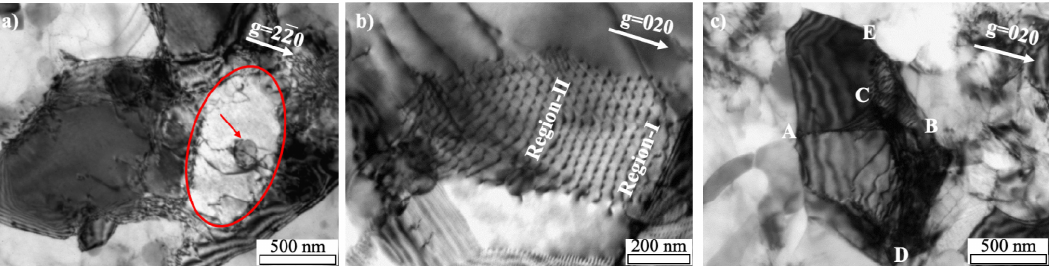
Figure 13. Evolution microstructure of AM5 annealed at 300 ◦ C for ( a ) 120 s and ( b , c ) 600